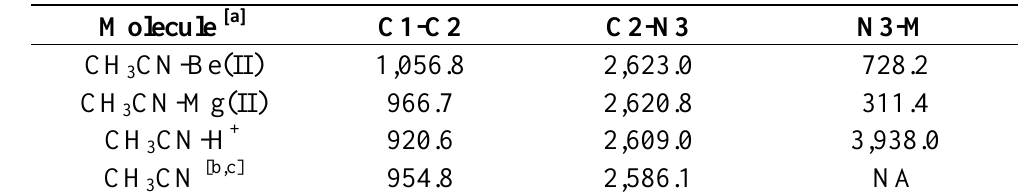
Table 7. Vibrational stretching frequencies (cm −1 ) of acetonitrile and its Be(II), Mg(II) and H +